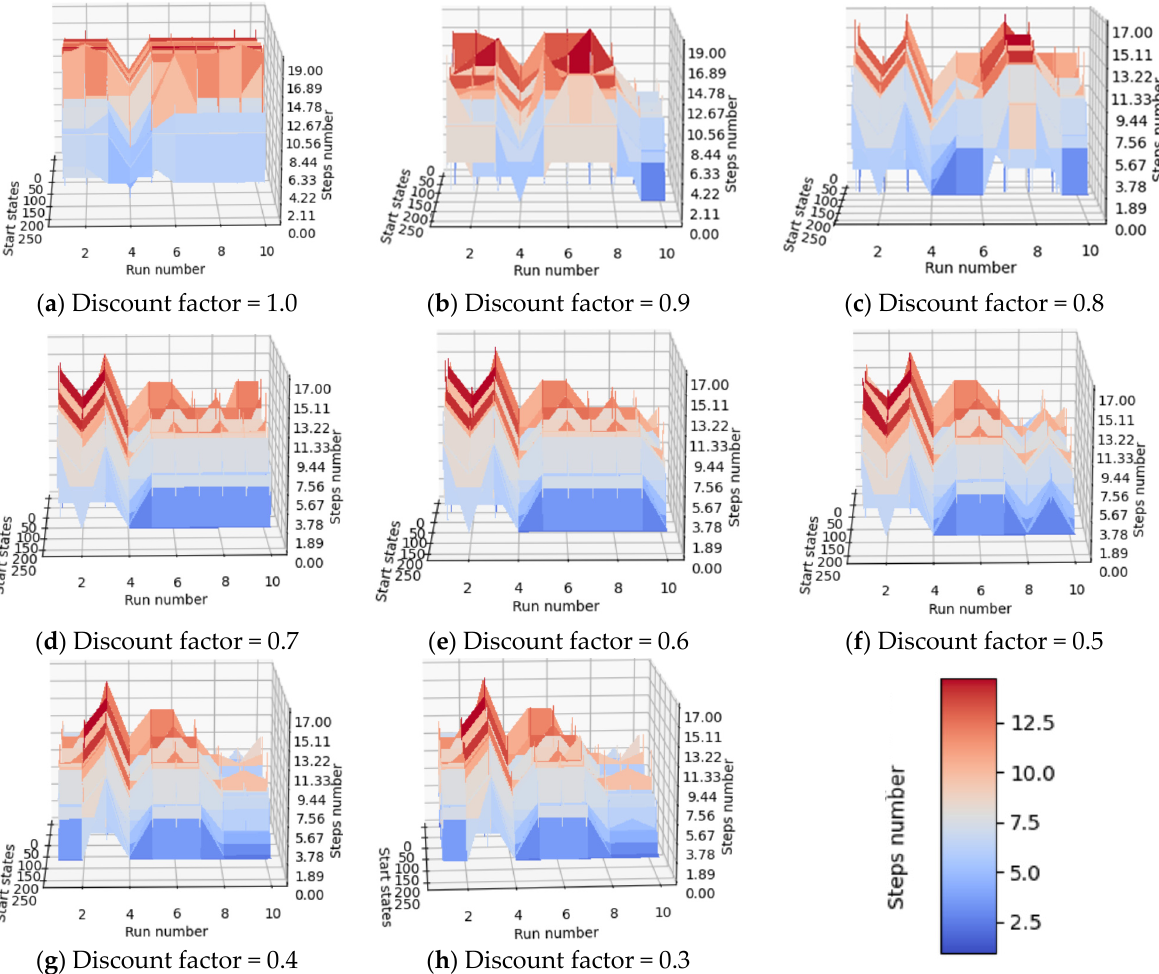
Figure 10. Models of trained agents vs. available initial states vs. number of steps required for agents to reach the desired final state starting from a given